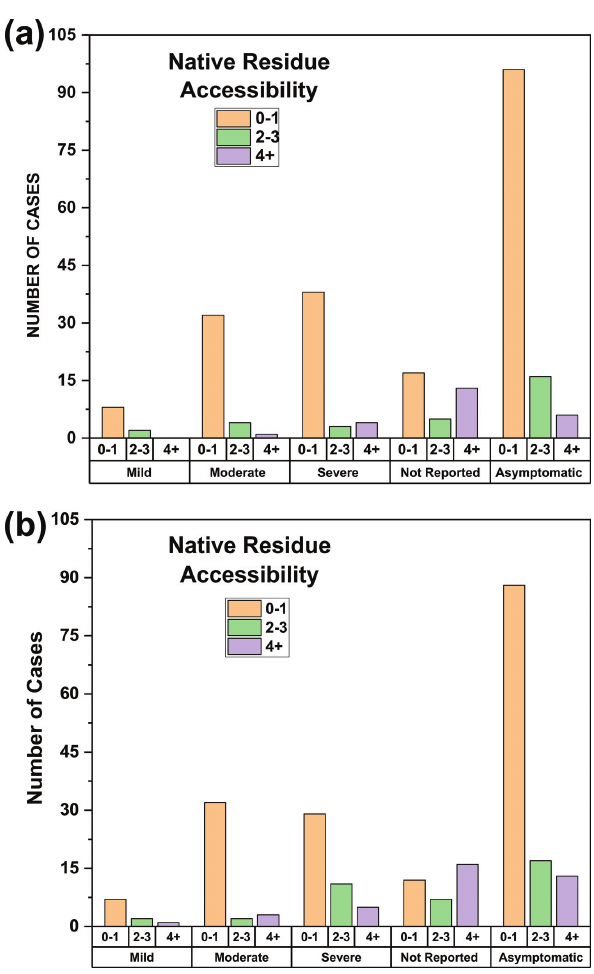
Fig. 7 Accessibility analyses of 100 missense variants associated with FV de fi ciency in the FV protein structure . ( a ) Accessibilities are presented for the full protein. FV variants in the intact cryo-EM structure (PDB ID: 7KVE) and the full-length AlphaFold structure ( ► Supplementary Fig. S1 ) were grouped by their phenotypic classi fi cation (bottom row). The variants were further subdivided according to the native residue accessibility (accessibilities of 0 ‐ 1, 2 ‐ 3 and 4 þ ) of the intact protein. The accessibility was determined using DSSP ( ► Supplementary Fig. S1 ). Accessibilities of 0 or 1 indicate side chain burial and values of > 1 indicate side chain exposure to solvent. ( b ) Accessibilities are presented for the six separated domains. FV variants were again grouped by phenotypic classi fi cation and accessibility. Here, accessibility refers to the change in residue accessibility when the cryo-EM FV structure (PDB ID: 7KVE) or the AlphaFold structure ( ► Supplementary Fig. S1 ) was separated into the six A1, A2, A3, B, C1, and C2 domains. Interdomain linkers are not included in this comparison. FV, Factor V.